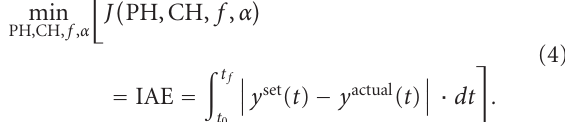
∗ Value for changes on the f .